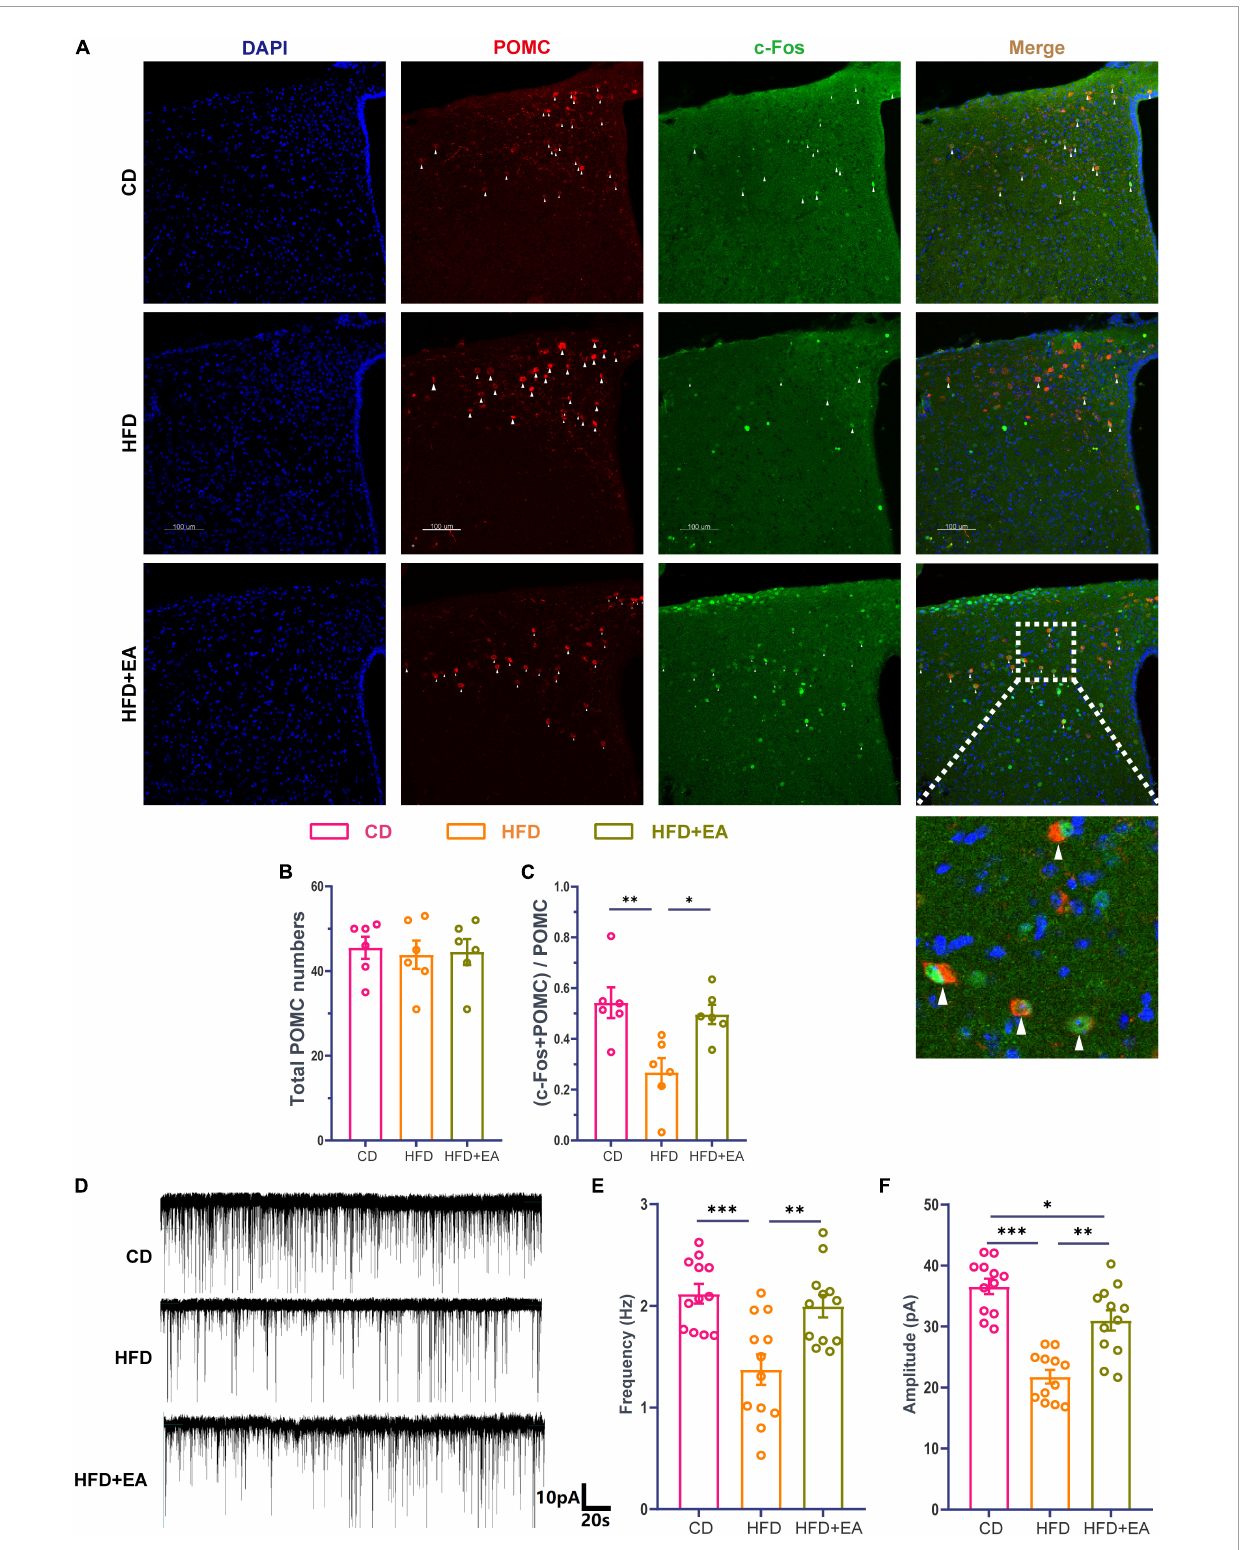
FIGURE3 EA treatments activate hypothalamic POMC neurons. (A) Co-labeled immunofluorescence representation of POMC neurons and c-Fos. (B) Total POMC neurons number. (C) Ratio of common standard count of POMC neurons and c-Fos in total POMC neurons. (D) Representation of sEPSCs in POMC neurons. (E) sEPSCs frequency of POMC neurons. (F) sEPSCs amplitude of POMC neurons. “n” in the immunofluorescence graph represents the number of slices, with 3 mice in each group. “n” in the patch clamp graph represents the number of cells (the number of mice in each group ≥ 3). CD: control group. HFD: high-fat diet group. HFD + EA: model + electroacupuncture group. ns P > 0.05; ∗ P < 0.05; ∗∗ P < 0.01; ∗∗∗ P < 0.001 (one-way analysis of variance with post hoc Bonferroni correction or Tamhane correction). Scale bars: 100 µ